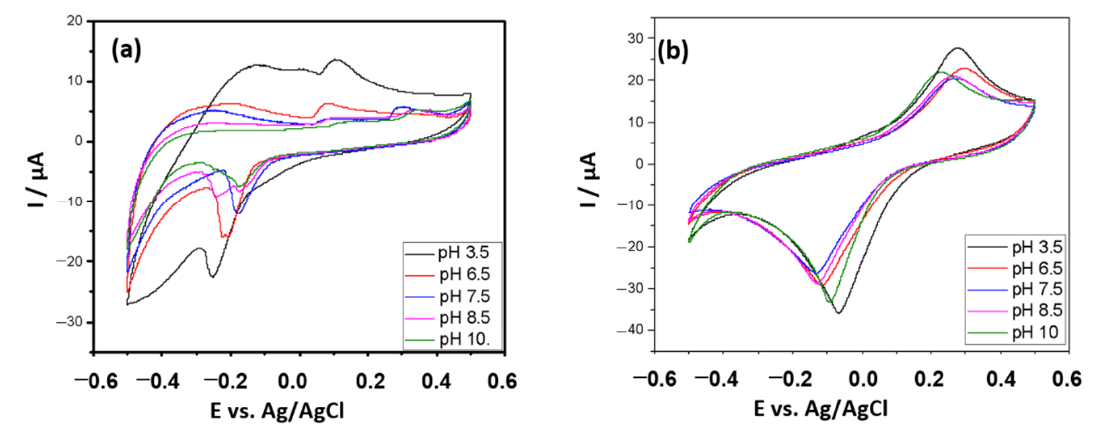
Figure 3. Evaluation of the effect of pH on the electrochemical behavior of the biosensor modified with ( a ) MBRS and ( b ) PB in K-PBS buffer as a function of the mediator’s immediate behavior. Scan rate: 50 mV · s −1 .